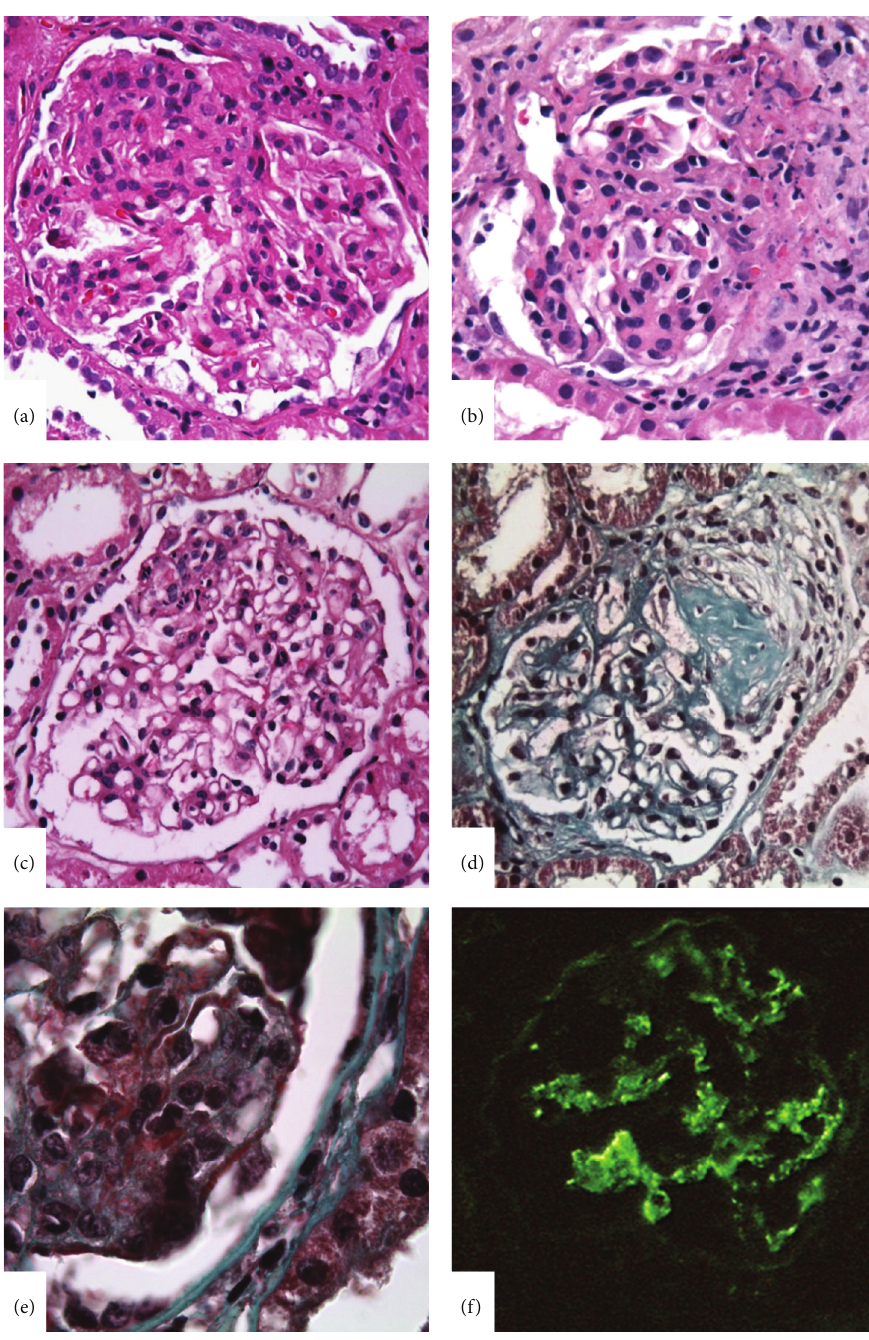
Figure 3: Lupus nephritis class III. (a) Segmental endocapillary hypercellularity with substantial luminal reduction. (b) Endocapillary hypercellularity with fibrinoid necrosis and cellular crescent formation. (c) Karyorrhexis in a segment of a glomerulus. (d) Segmental sclerosis of a glomerulus. (e) Segmental subendothelial deposits by light microscopy as fuchsinophilic deposits in Masson Trichrome stain. (f) IgG immune deposits in glomerular capillary wall in segmental distribution and also accompanying mesangial deposits (IFM, ×